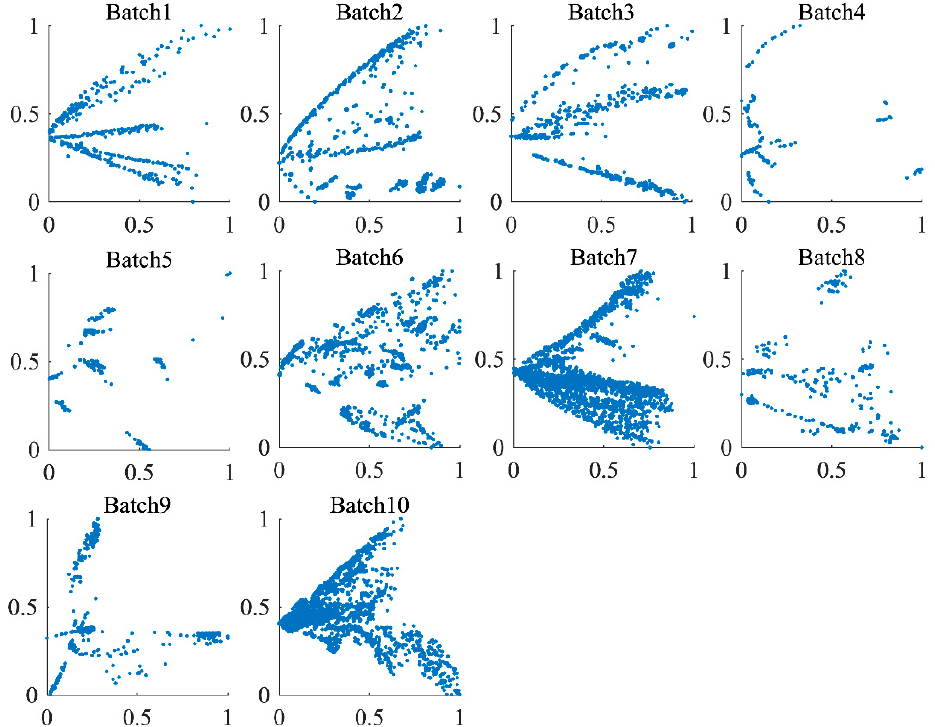
Figure 3. Dot diagram of 10 batches of data after PCA dimensionality reduction after domain trans- formation.